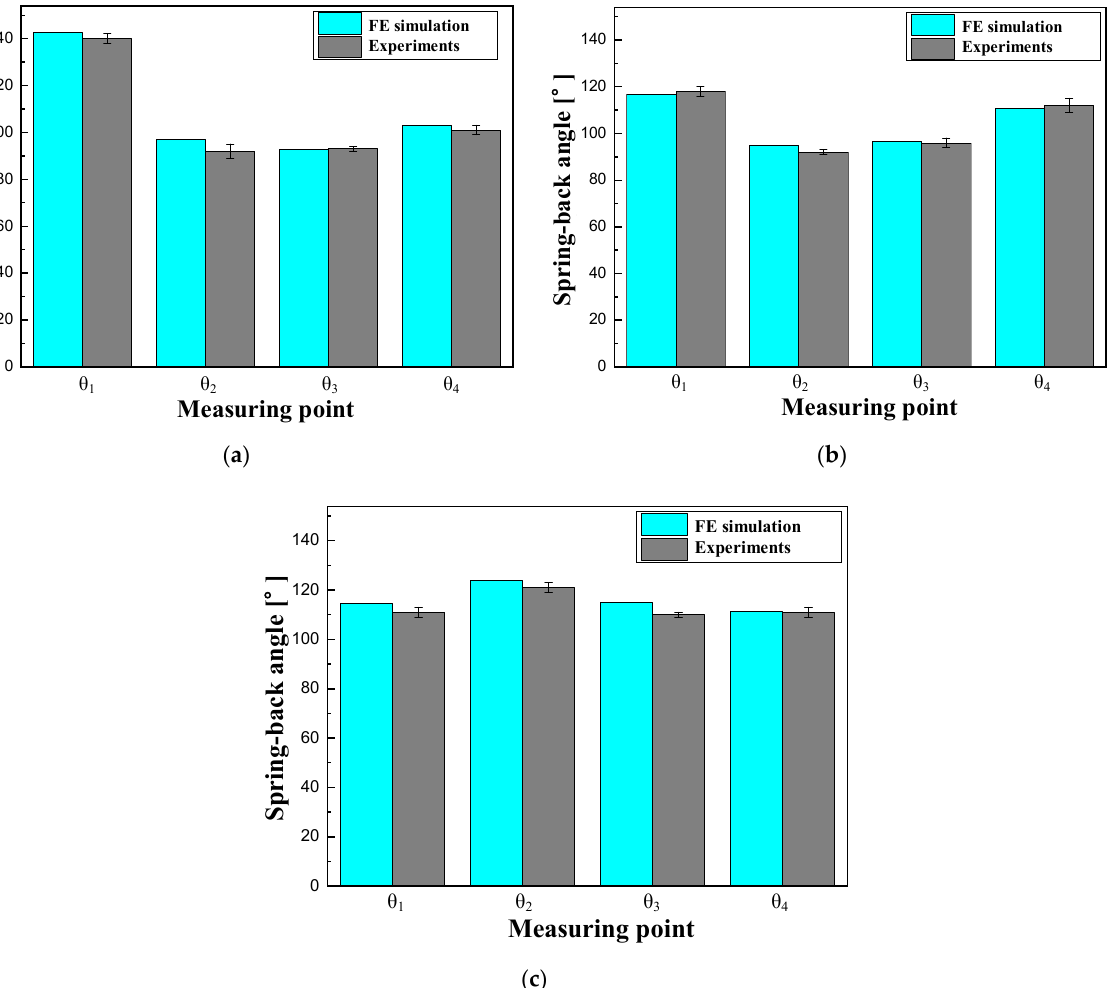
Figure 11. Comparison of the spring-back between the analytical results and experimental results. ( a ) Cross-section at A. ( b ) Cross-section at B. ( c ) Cross-section at C.